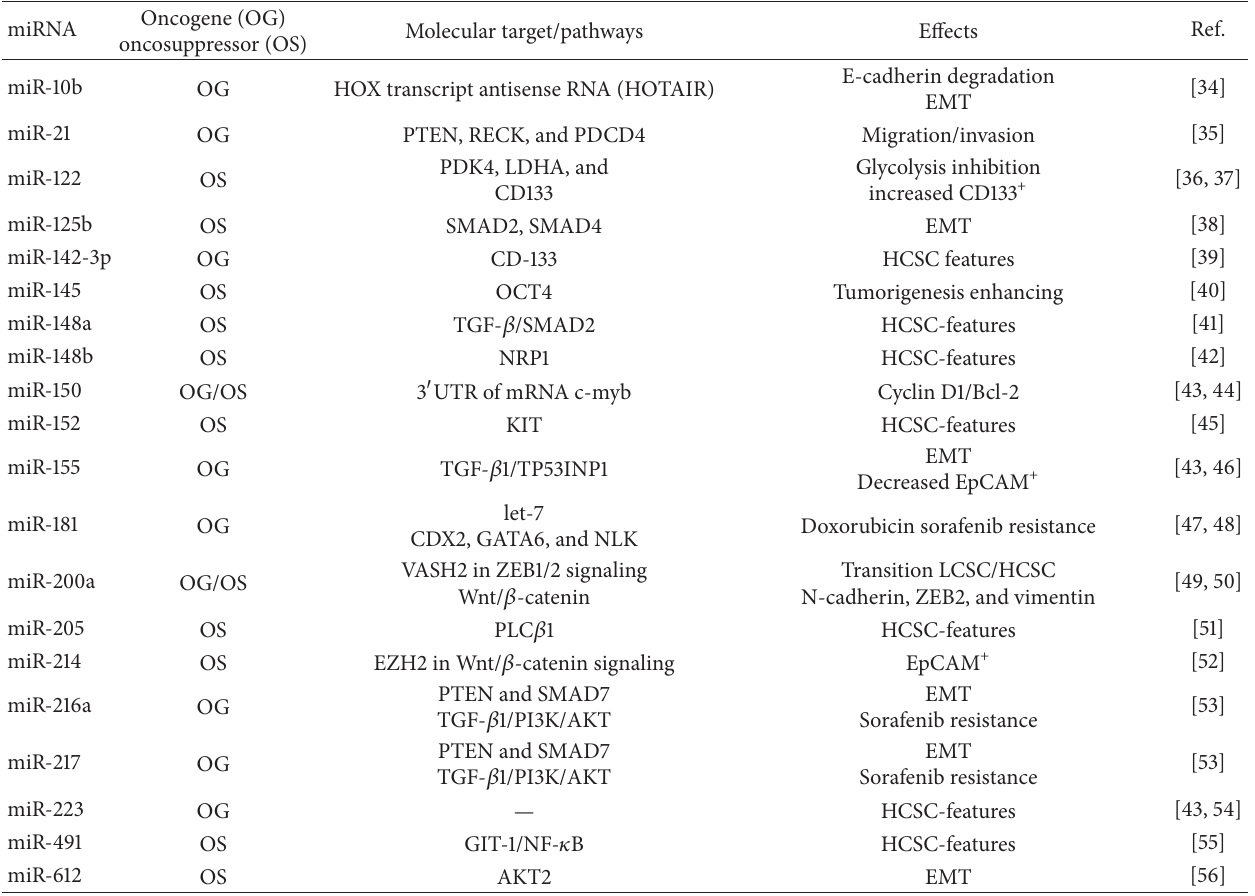
Table 2: The regulatory functions of miRNAs in HCSCs